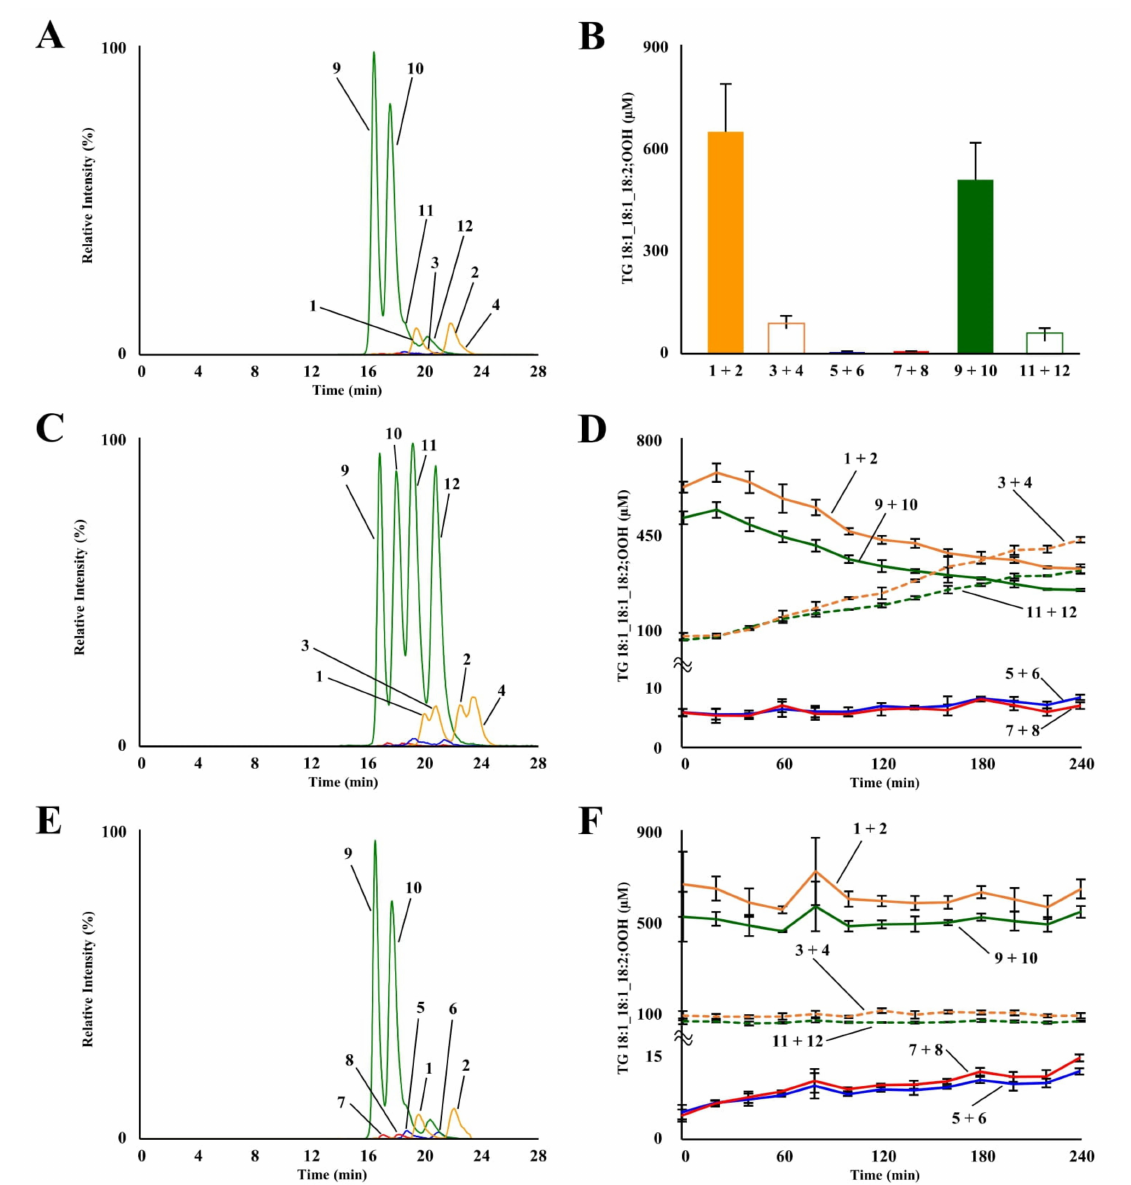
Figure 2. MRM chromatograms of TG 18:1_18:1_18:2;OOH isomers in fresh EVOO ( A ). Refer to Table 1 for peak numbers. Concentration of TG 18:1_18:1_18:2;OOH isomers in fresh EVOO ( B ). MRM chromatograms ( C ) and concentration ( D ) of TG 18:1_18:1_18:2;OOH isomers in thermal- oxidized EVOO. MRM chromatograms ( E ) and concentration ( F ) of TG 18:1_18:1_18:2;OOH isomers in photo-oxidized EVOO. Mean ± SD (n =